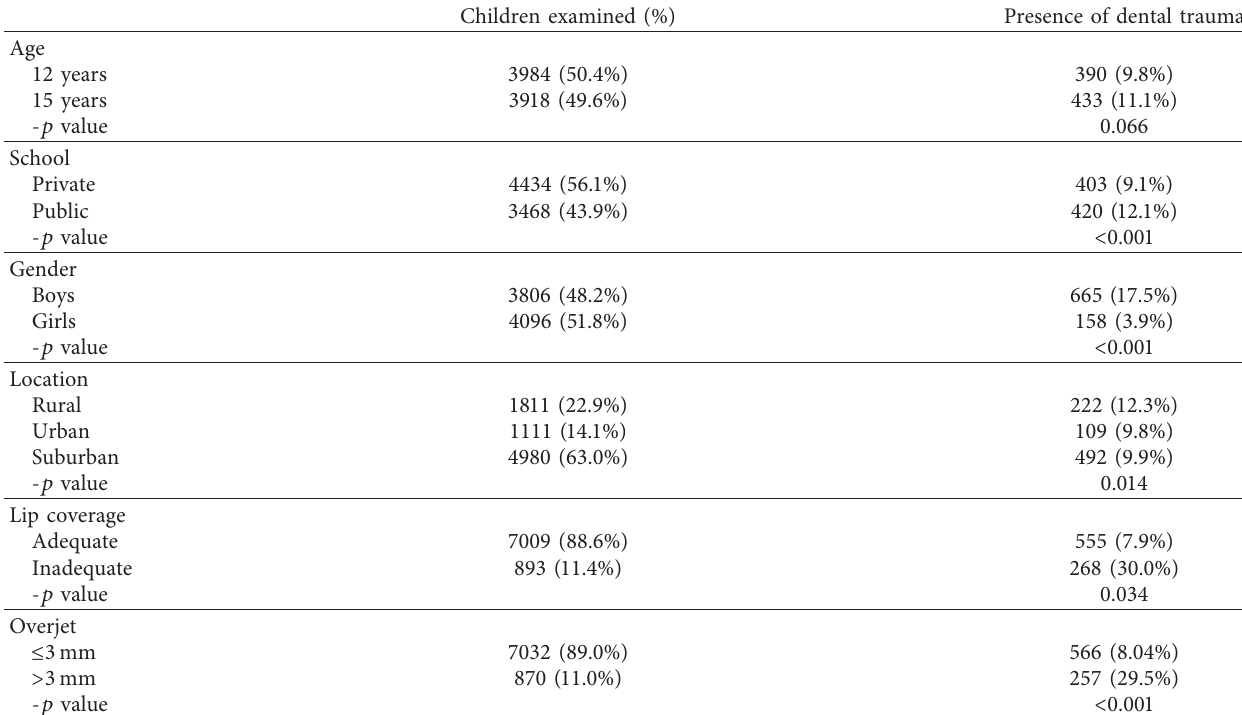
Table 1: Univariate analyses of the factors associated with presence of dental trauma.